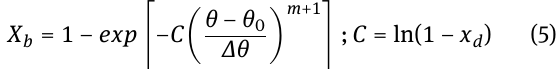
release equation [10, 15, 24]. The resultant pressure